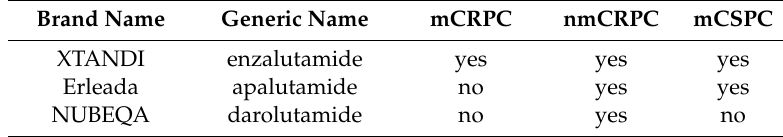
Figure 3. Second generation of nonsteroidal AR antagonists. Table 2. FDA-approved second-generation AR antagonists for prostate cancer.